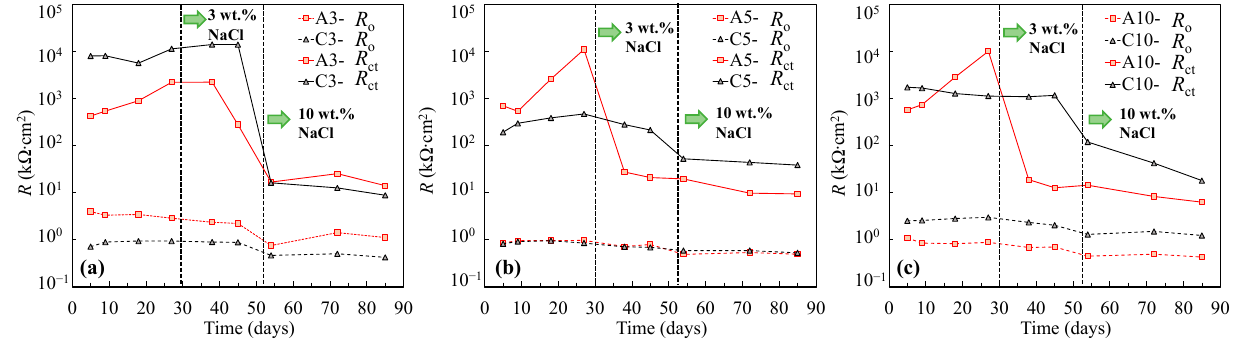
Figure 9. Adjusted Bode plots of the tensile-stressed specimens in coupled cells: ( a ) C3; ( b ) C5; ( c ) C10.